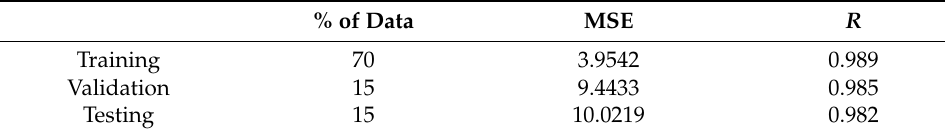
Figure 13. Comparison of NARX outputs and target joint angles in reduced space (single channel). Table 1. Regression value of the proposed model.